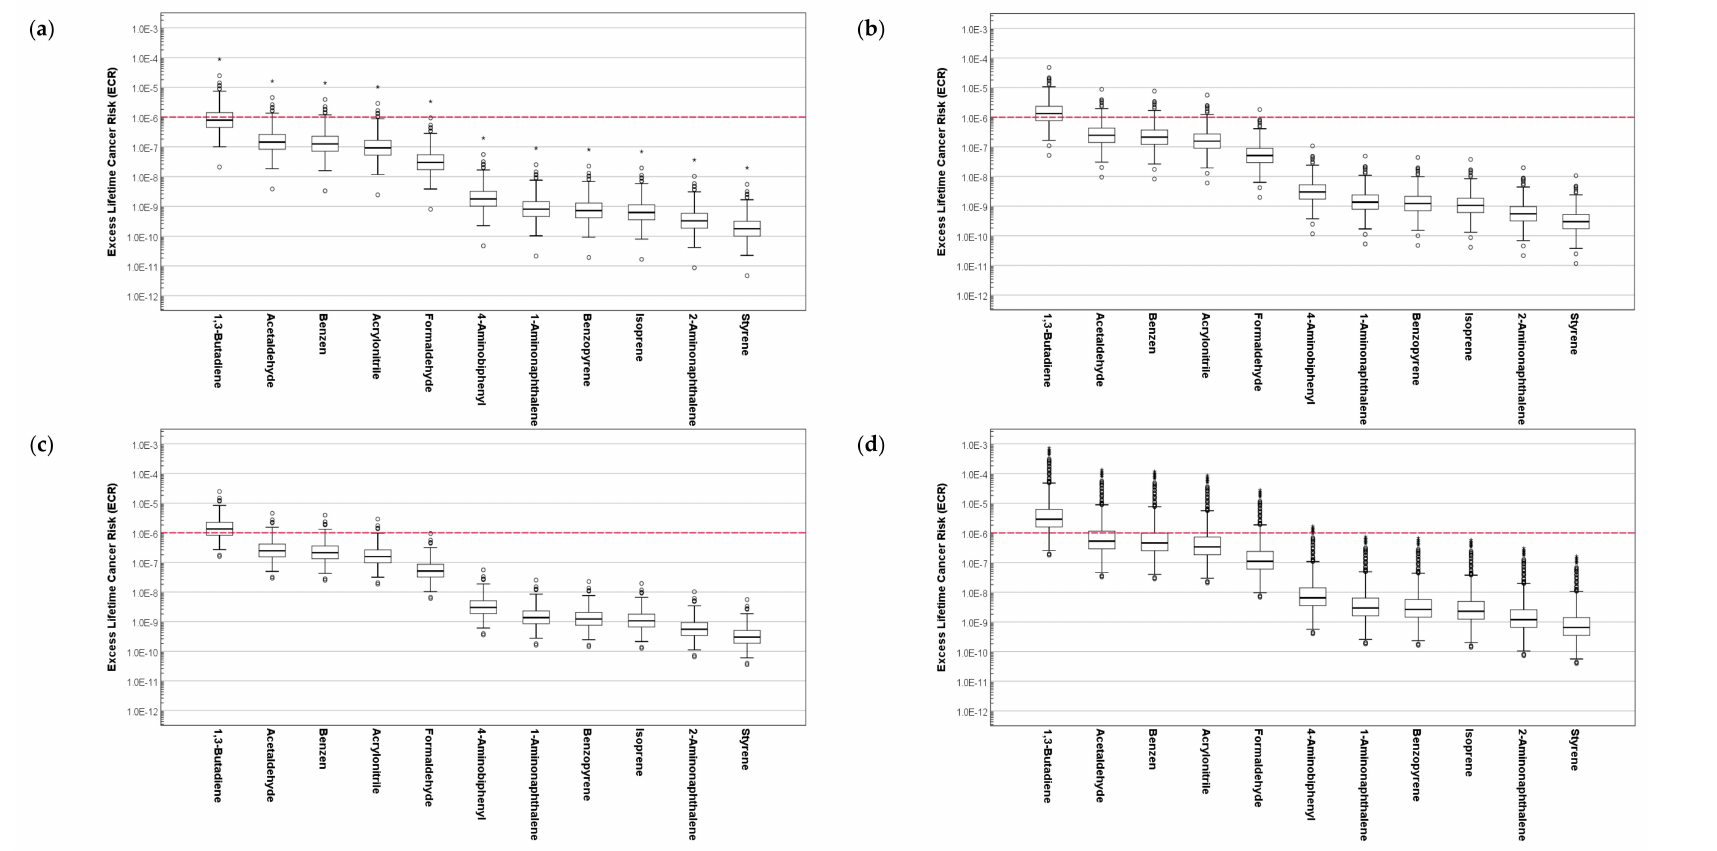
Figure 6. Assessment of excess lifetime cancer risk for the composition of cigarette smoke to THS exposure subjects based on age: ( a ) 6–10 years old, ( b ) 11–13 years old, ( c ) 14–18 years old, and ( d ) 19 years old and